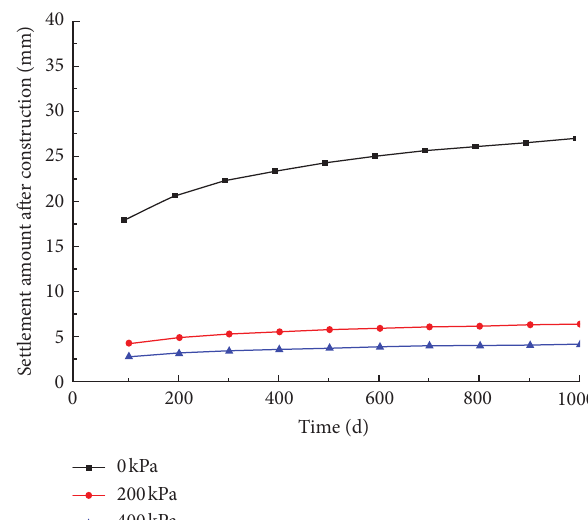
Figure 15: The calculation results of creep deformation under different preload conditions.